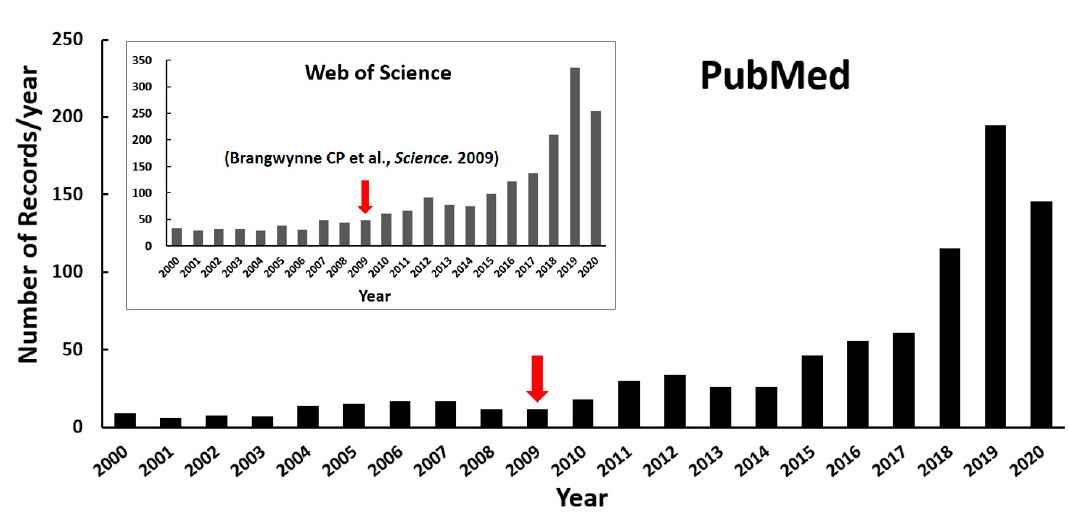
Figure 1. Number of publications on protein LLPS investigation over the past twenty years (until the end of August in 2020). The retrieval was performed with the keyword combinations “((liquid − liquid phase separation) OR (liquid − liquid phase transition)) AND (protein)” from NCBI PubMed as well as Web of Science (inserted figure). The red arrows highlight Brangwynne CP and coworkers’ publication shown in 2009.